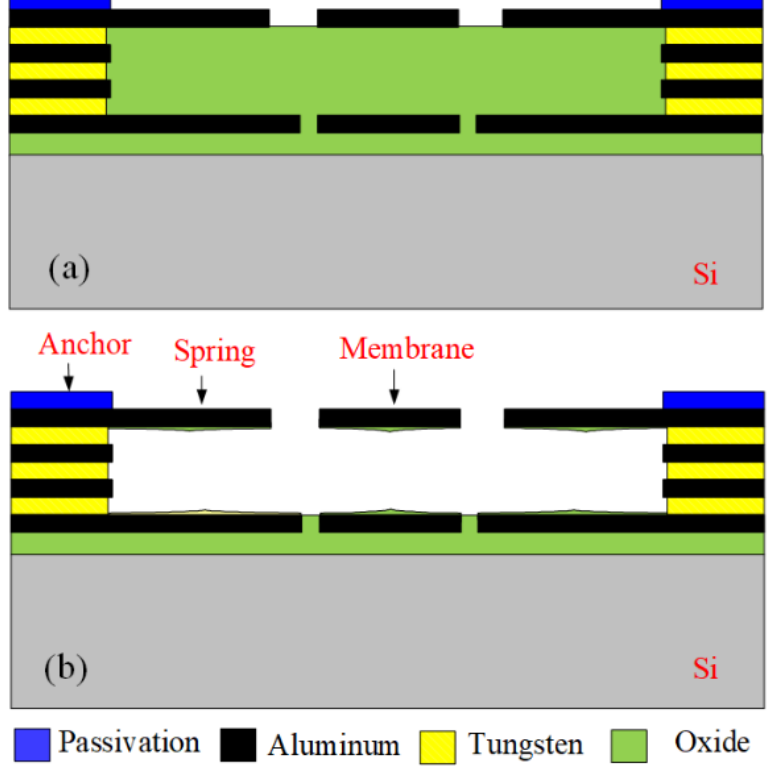
Figure 8. Process flow of the MSS: ( a ) after the complementary metal oxide semiconductor (CMOS) process; and ( b ) etching oxide layer.